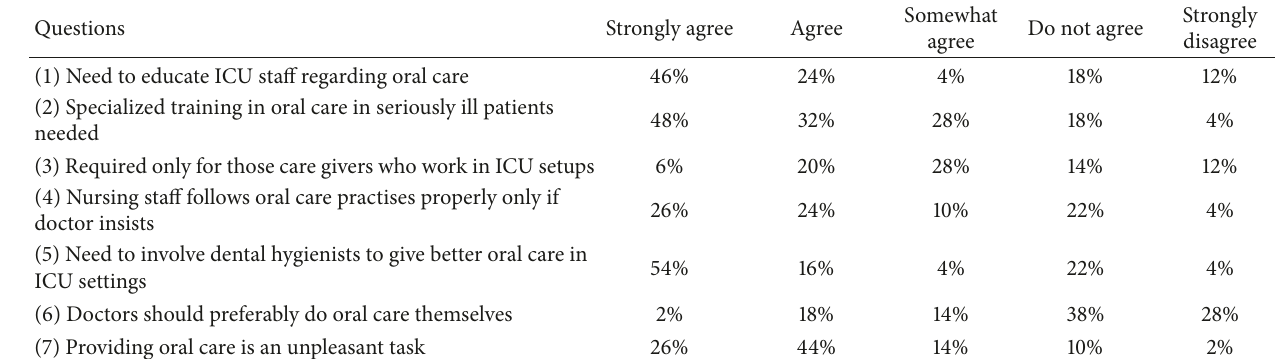
Table 2: Assessment of attitude towards oral care in ICU